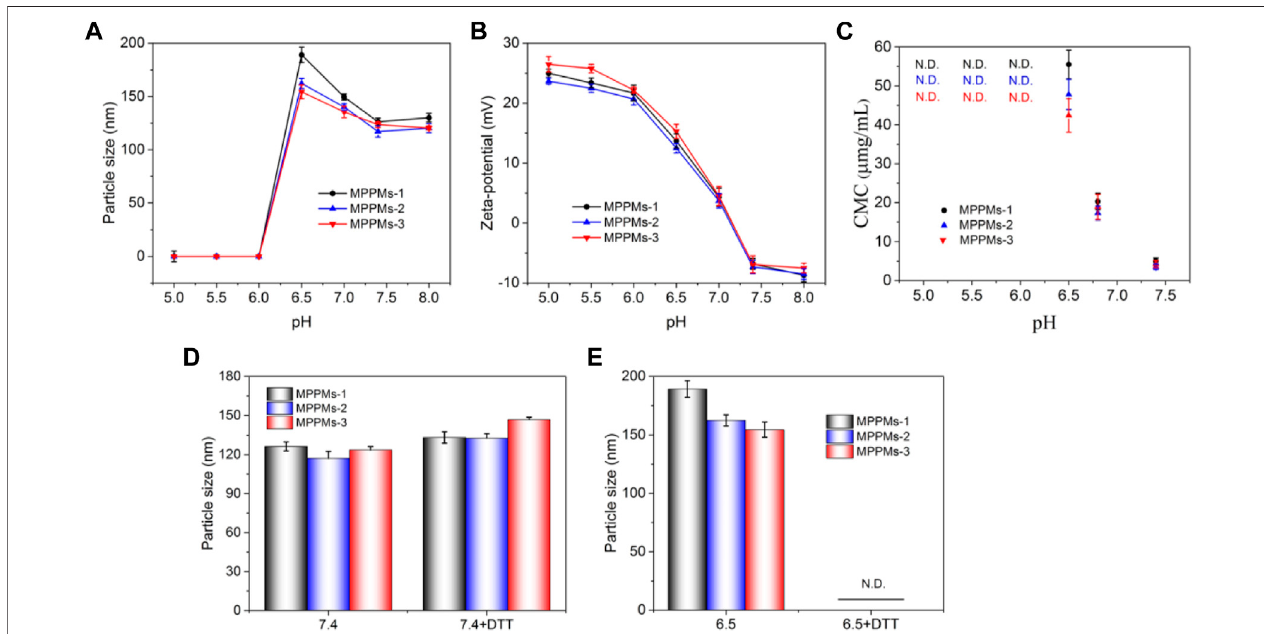
FIGURE4| Particlesize (A) and zeta-potential (B) ofMPPMs-1, MPPMs-2,and MPPMs-3in PBSwithdifferent pHvalues after incubation for4 h. CMC values (C) ofthreeMPPMssystemsdependentonpHvalues.ParticlesizeofMPPMs-1,MPPMs-2,andMPPMs-3inPBSatdifferentconditions: (D) pH7.4withorwithout10 mM DTT and (E) pH 6.5 with or without 10 mM DTT) after incubation for 4 h ( n = 3, mean ±